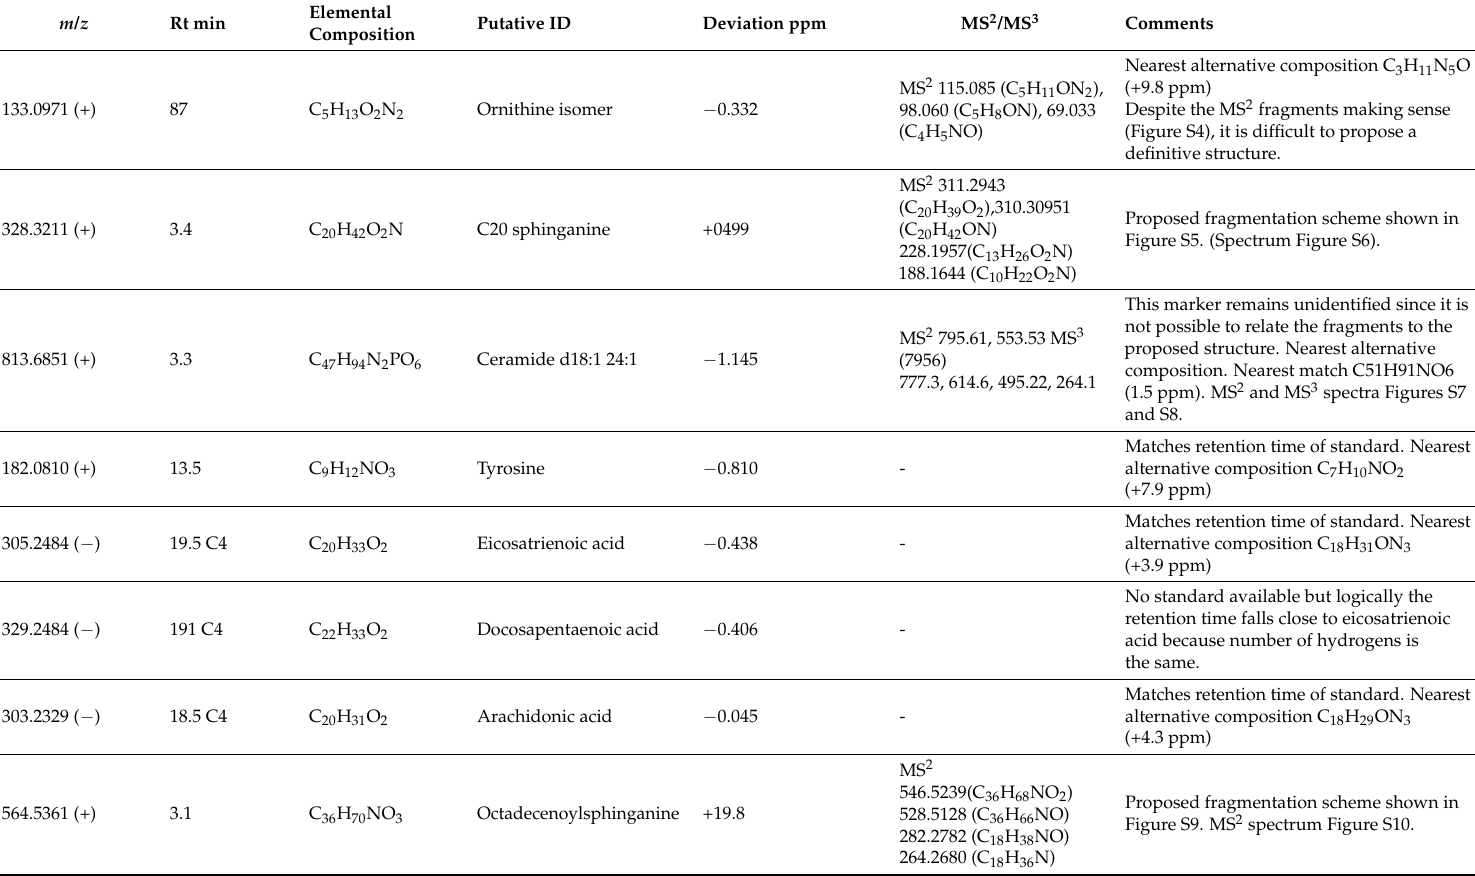
Table 4. Details of characterization of the eight marker compounds shown in Table 1 obtained in positive (+) or negative ( − ) ion mode. MS n fragments obtained at 30 V collision energy for three of the marker compounds shown in Table 3 obtained by using an Orbitrap Fusion mass spectrometer at 50000 resolution in MS 2 mode and low resolution in MS 3 mode. Chromatography carried out on ZICpHILIC or and ACE C4 column